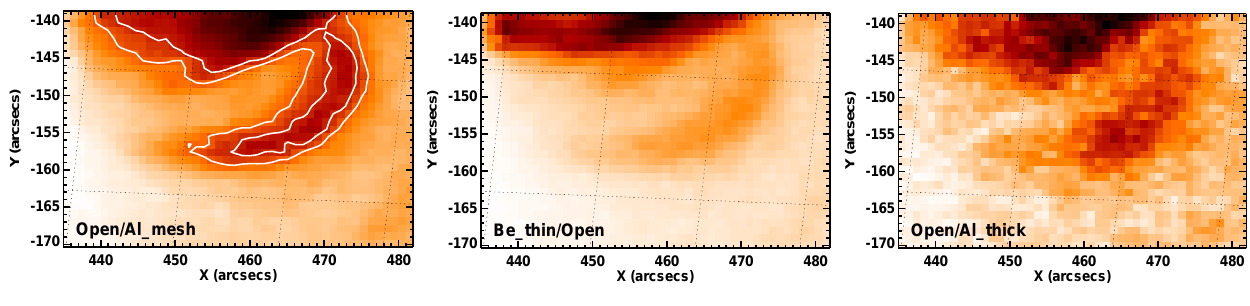
Fig. 6. Images of the loop observed in active region NOAA 09555 around 18:00UT, taken in three different Hinode /XRT filters. Contours overplotted on an Al mesh filter image corresponds to 0.6 and 0.8 of the maximum flux of the loop.